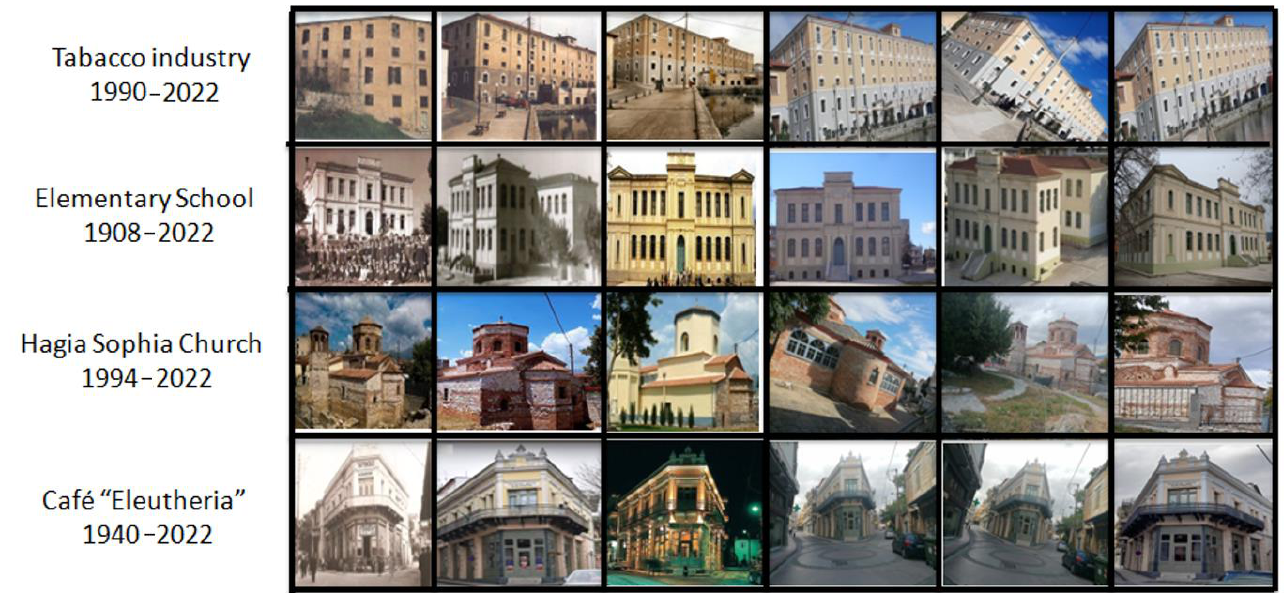
Figure 7. Landmarks samples from the dataset of Drama city.